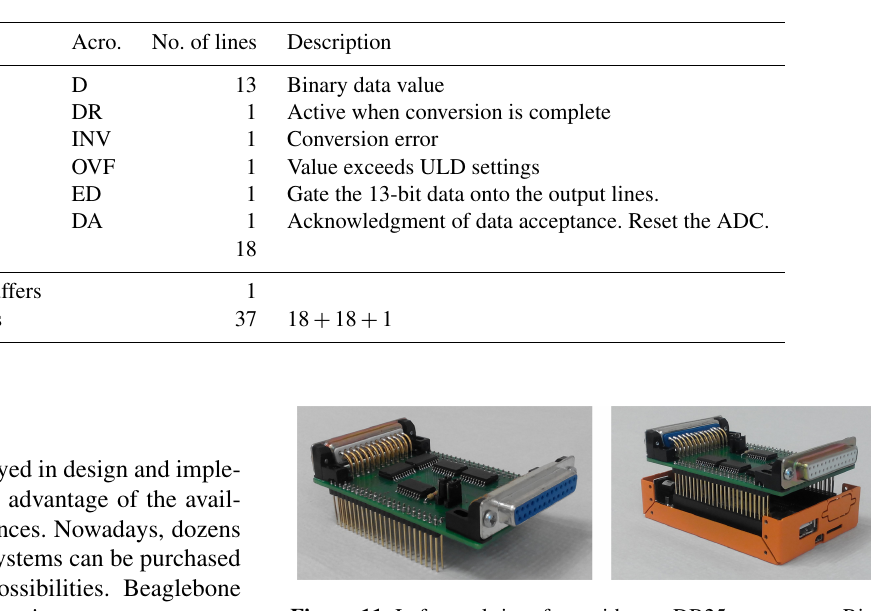
Figure 11. Left panel: interface with two DB25 connectors. Right panel: interface mounted on the process platform (Beaglebone Black)